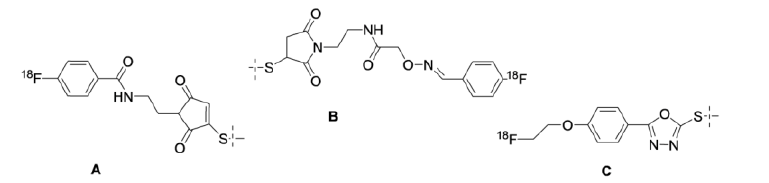
Figure 2. Structures of non-residualizing radioiodine labels provided by the labeling of affibody molecules using PIB ( A ), IHPEM ( B ), and IPEM ( C ).